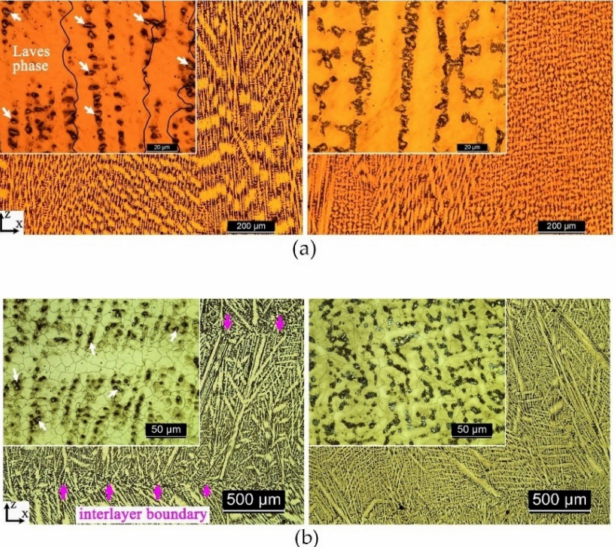
Figure 18. Microstructure of IN718 through WAAM: ( a ) unrolled; ( b ) rolled. Reprinted from Ref.